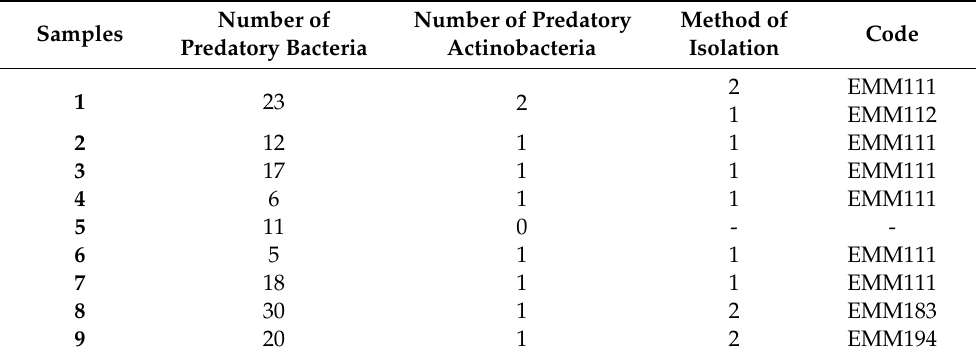
(Table 1). The selection was based on the following criteria: growth after 72–96 h of incubation, consistency, pigmentation of substrate and aerial mycelium, microscopic observation, and specific features defined by the ISP. Table 1. Origin and number of predatory Actinobacteria isolates.